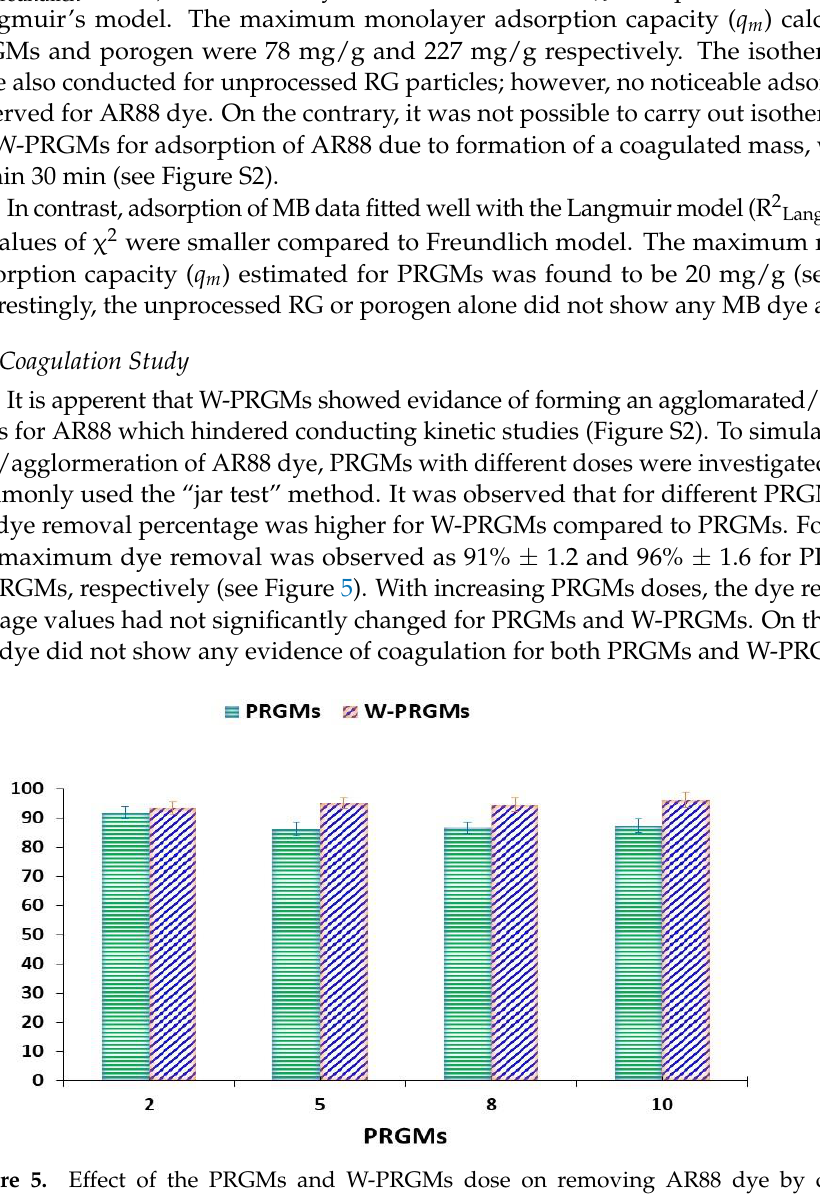
Figure 5. Effect of the PRGMs and W-PRGMs dose on removing AR88 dye by coagulation. (C 0 = 200 mg/L, pH = 2.5, dye volume = 10 mL; T = 22 ± 2 °C